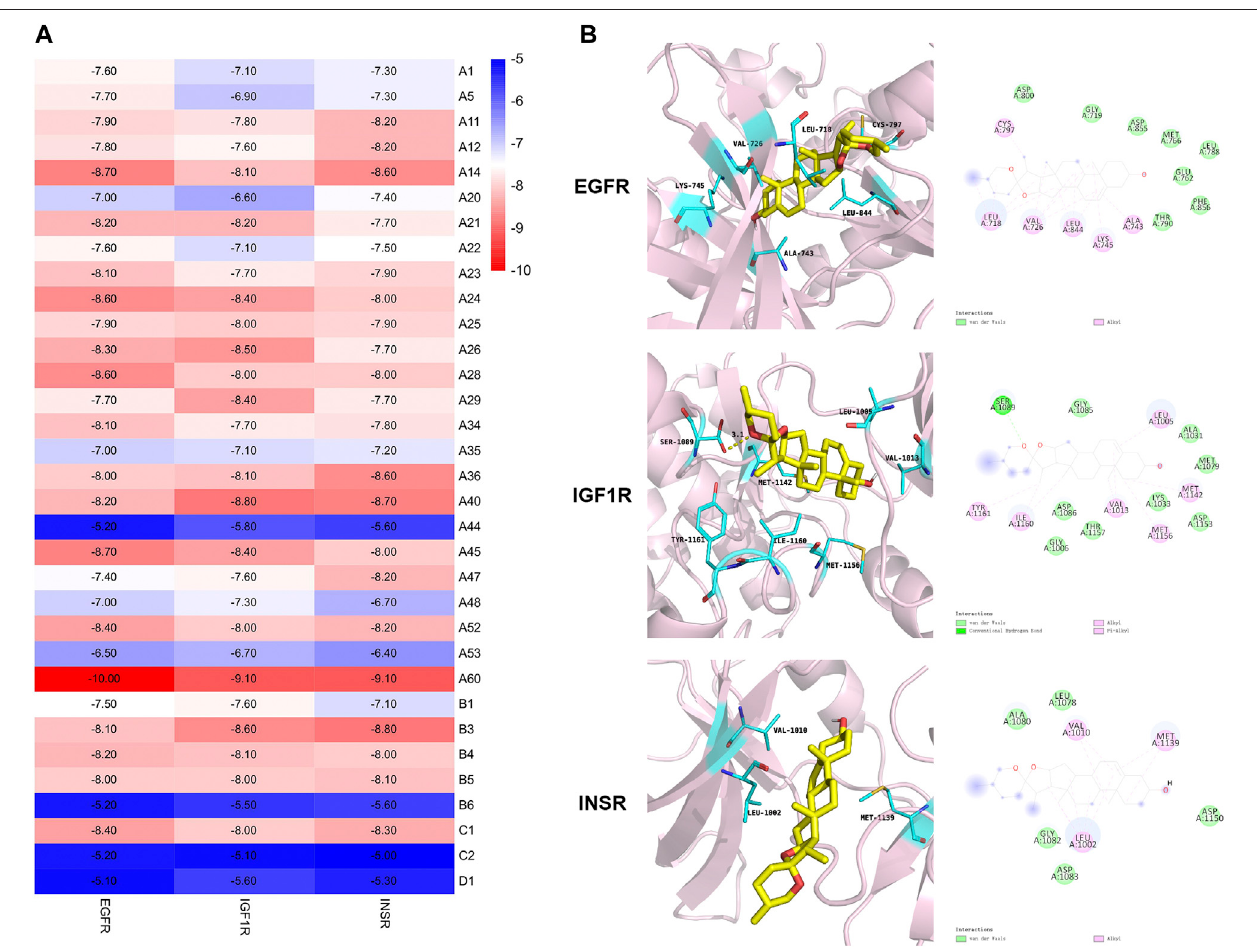
FIGURE 7 | Molecular docking based on the binding af fi nity. (A) Heat map showing the af fi nity. (B) Stereoviews and binding poses of diosgenin (A60) optimal conformation docked to EGFR, IGF1R, and INSR.